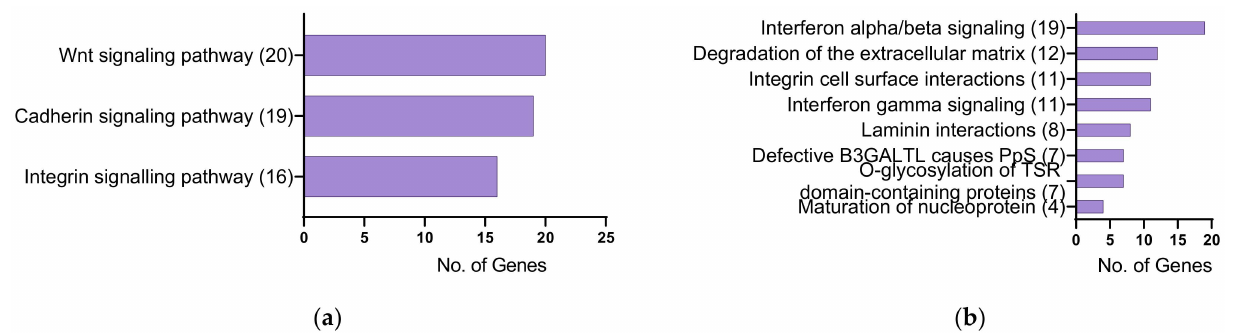
Figure 3. Gene ontology terms showing ( a ) biological processes, ( b ) molecular functions and ( c ) cellular components of significant differentially expressed genes in HKCs (TGF β 1 + CMS) vs. HCFs (TGF β 1 + CMS) (FDR ≤ 0.05). Numbers in brackets are the number of genes involved in each process.